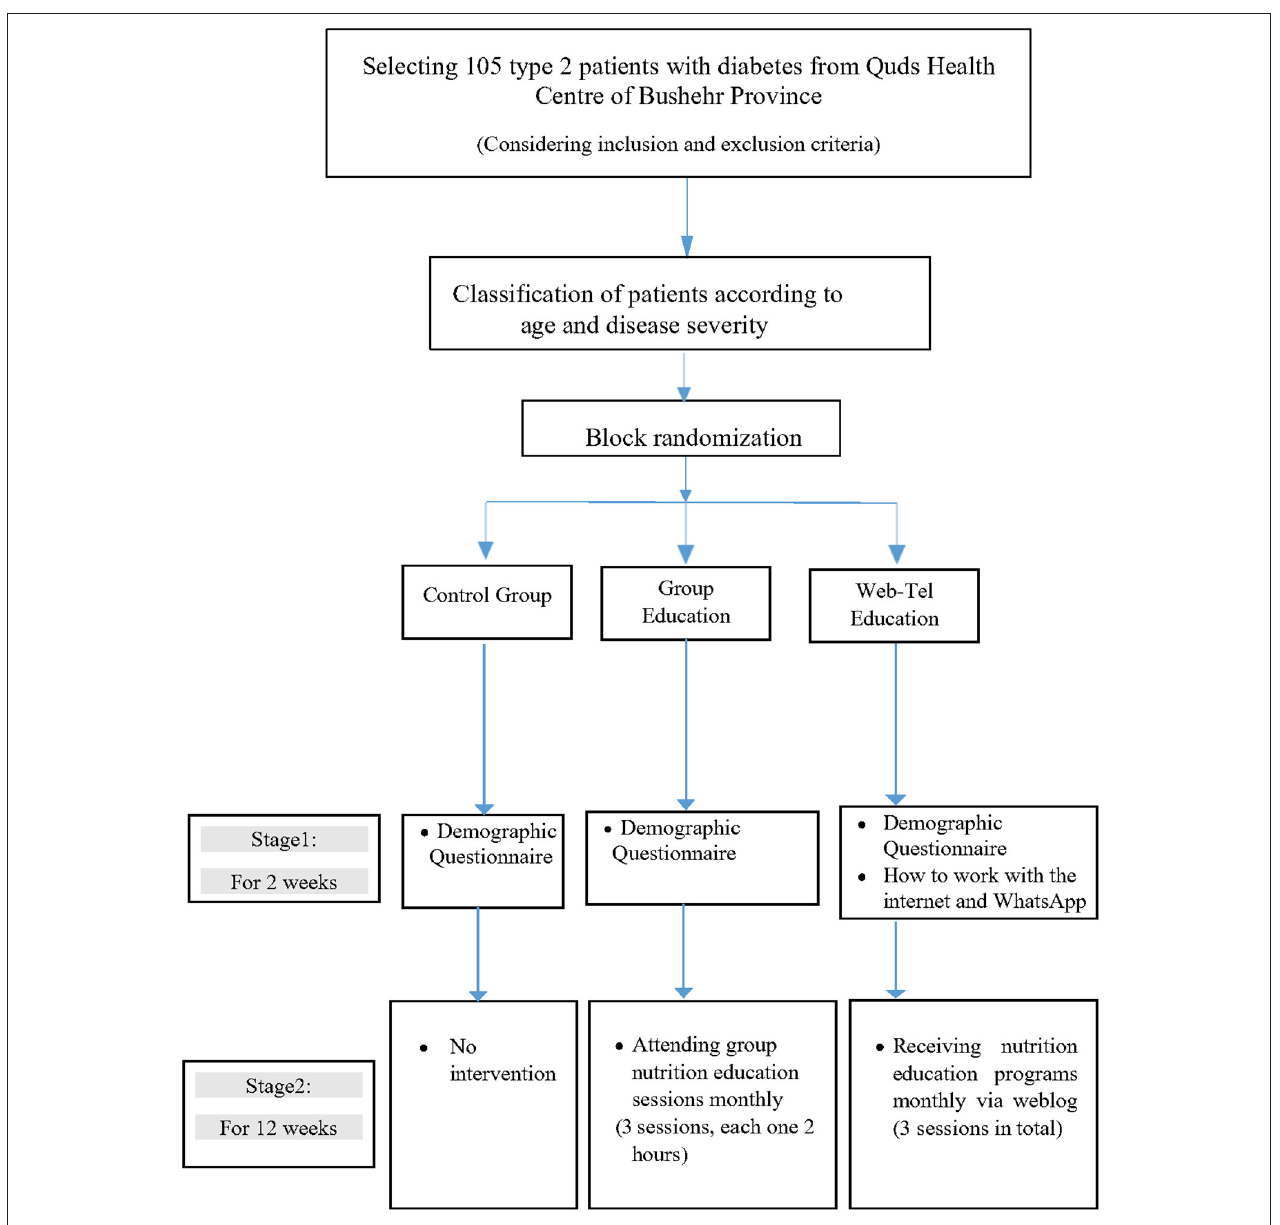
FIGURE 1 | Summary of intervention on patients with type 2 diabetes mellitus